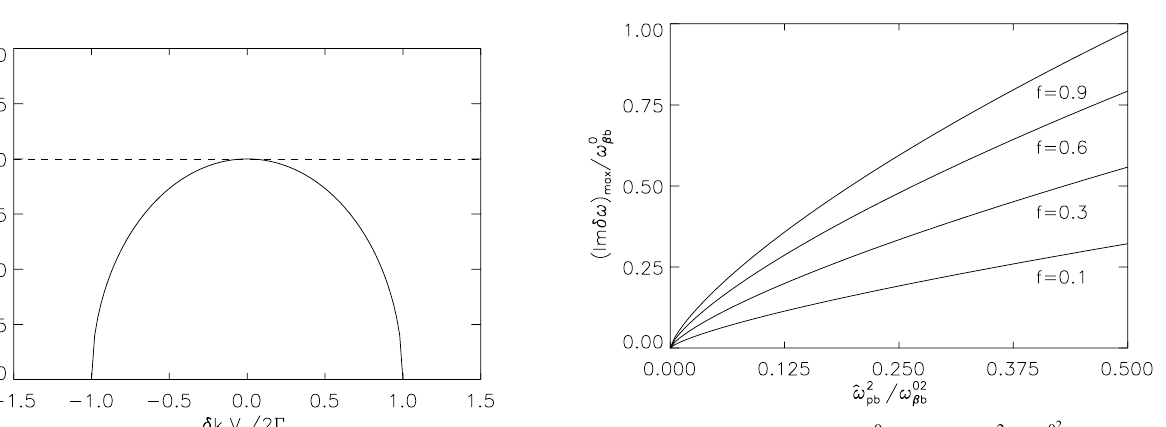
FIG. 6. Plot of (cid:115) Im dv (cid:100) max (cid:121) v (cid:48) b (cid:98) versus (cid:195) v (cid:50) (cid:112)(cid:98) (cid:121) v (cid:48) (cid:50) b (cid:98) calculated from Eq. (96) for v (cid:48) b (cid:101) (cid:173) (cid:48) , g (cid:98) (cid:173) (cid:49)(cid:46)(cid:56)(cid:53) , (cid:90) (cid:98) (cid:173) (cid:49) , (cid:109) (cid:98) (cid:121) (cid:109) (cid:101) (cid:173) (cid:49)(cid:56)(cid:51)(cid:54) , (cid:114) (cid:98) (cid:121) (cid:114) (cid:119) (cid:173) (cid:48)(cid:46)(cid:53) , and several values of fractional charge neutralization corresponding to (cid:102) (cid:173) (cid:48)(cid:46)(cid:49) , (cid:48)(cid:46)(cid:51) , (cid:48)(cid:46)(cid:54) , and (cid:48)(cid:46)(cid:57)